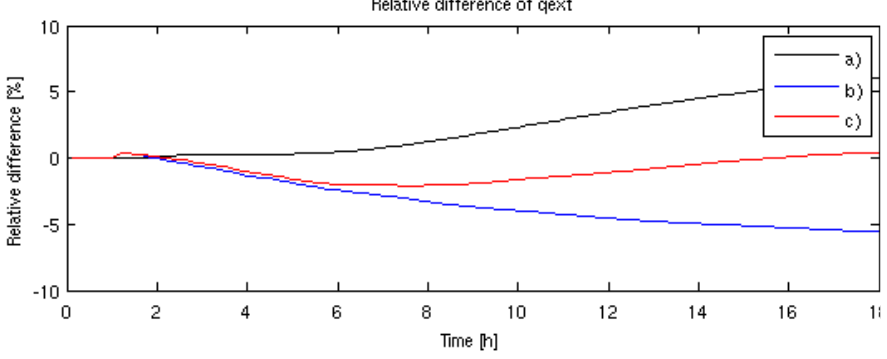
Fig. 12. The relative difference of the light extinction coefficient. In the legend (a) stands for comparison between reallocated and full moving Figure 12: The relative difference of the light extinction coefficient. In the legend a) models, (b) for full moving vs. sectional and (c) for reallocated vs. sectional models. stands for comparison between reallocated and full moving models, b) for full moving vs. sectional and c) for reallocated vs. sectional model.